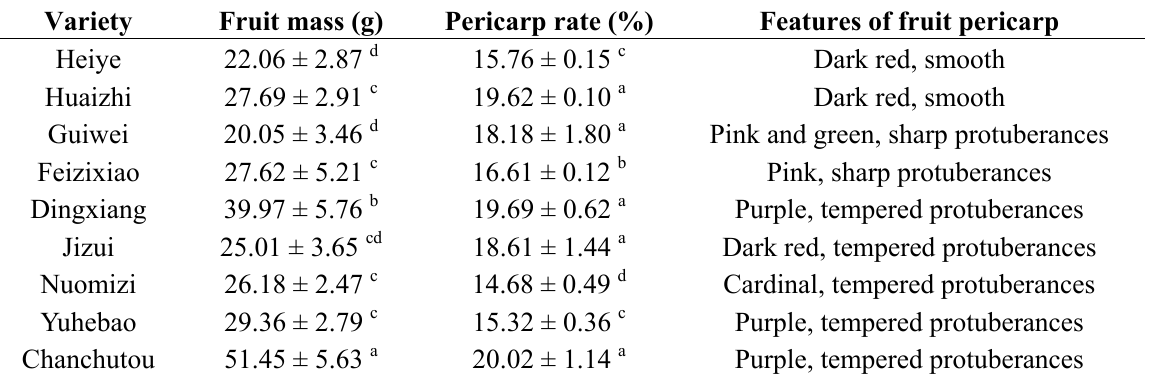
Table 4. Description of the nine different litchi cultivars. Variety Fruit mass